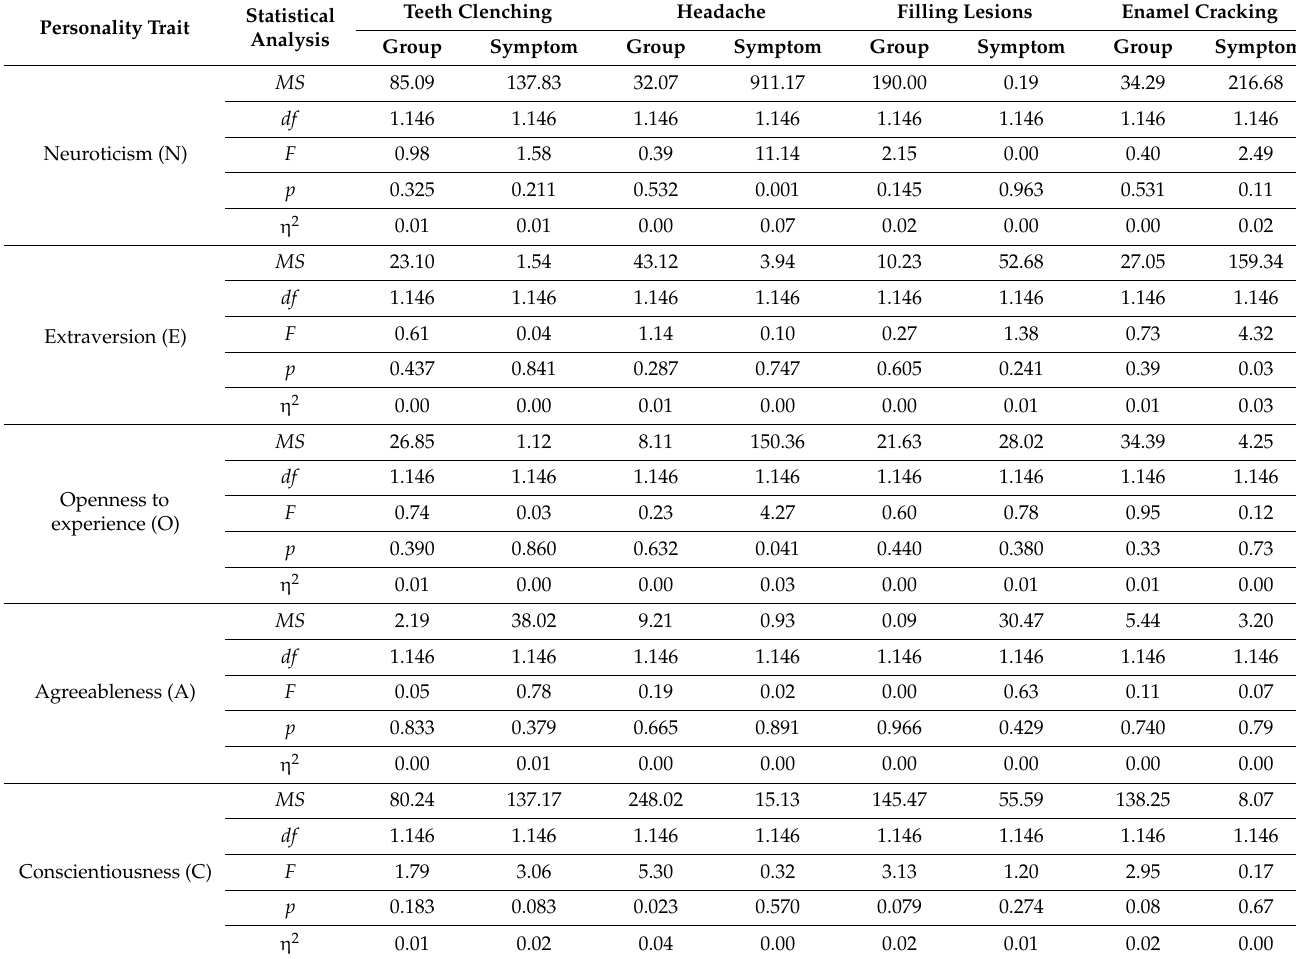
Table 1. The results of the ANOVA 2 × 2 analysis for the differentiation of personality traits expressed by the presence of disorders of the masticatory system and belonging to the studied